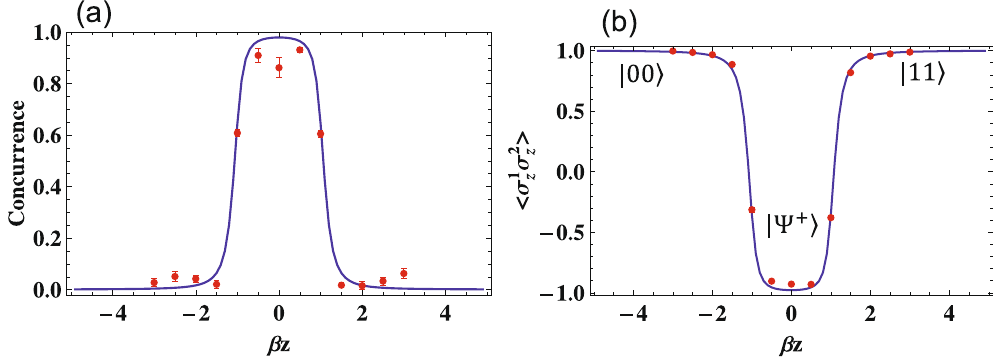
Figure 3. ( a ) Measured concurrence of the simulated ground state of the two-spin Ising model v.s. the dimensionless longitudinal field strength β z and fixed transverse filed strength β x = 0.15, compared to the theoretical prediction (solid line). ( b ) Measured two-spin correlation σ σ theoretical prediction. Error bars indicate the statistical uncertainty and are estimated with Monte Carlo simulation. Some of them are smaller than portrayed by the